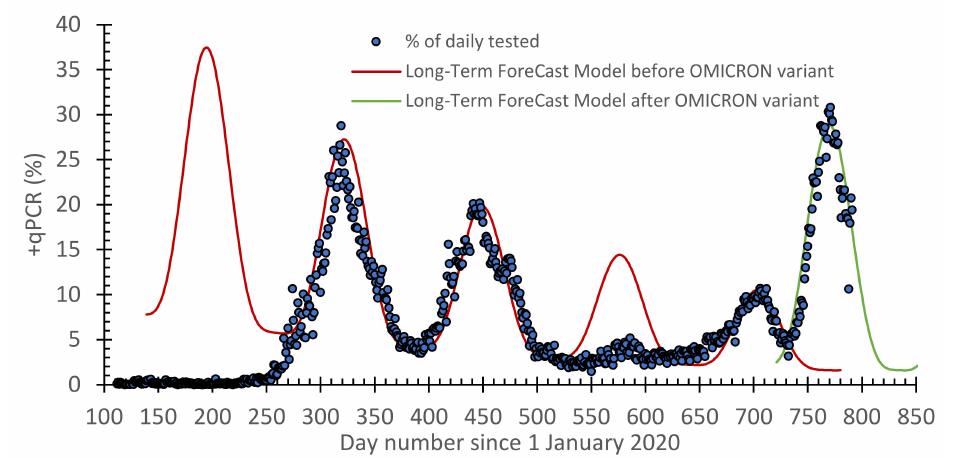
Figure 4. A timeline for the daily reported +qPCR tests overlayed by the long-term forecast (LTF) model predictions for the COVID-19 pandemic in Jordan before and after the emergence of the OMCIRON